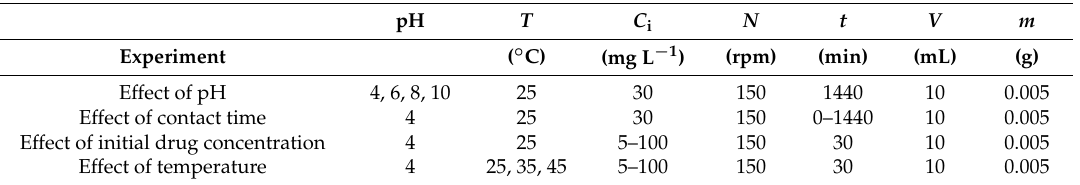
Table 1. Adsorption experimental conditions for adsorption of DCF from aqueous media by chitosan